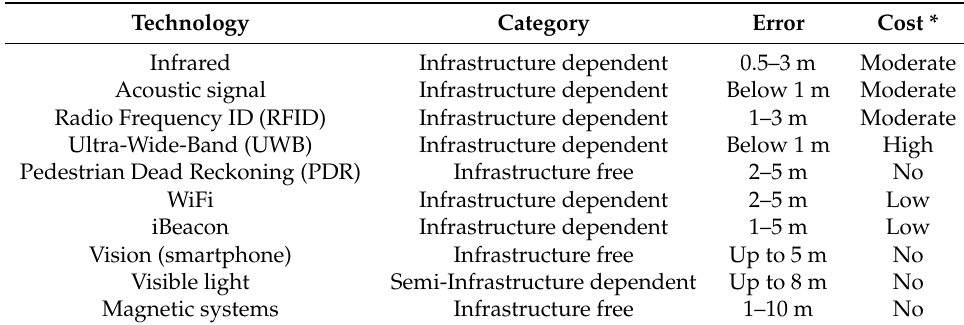
Table 1. Indoor localization